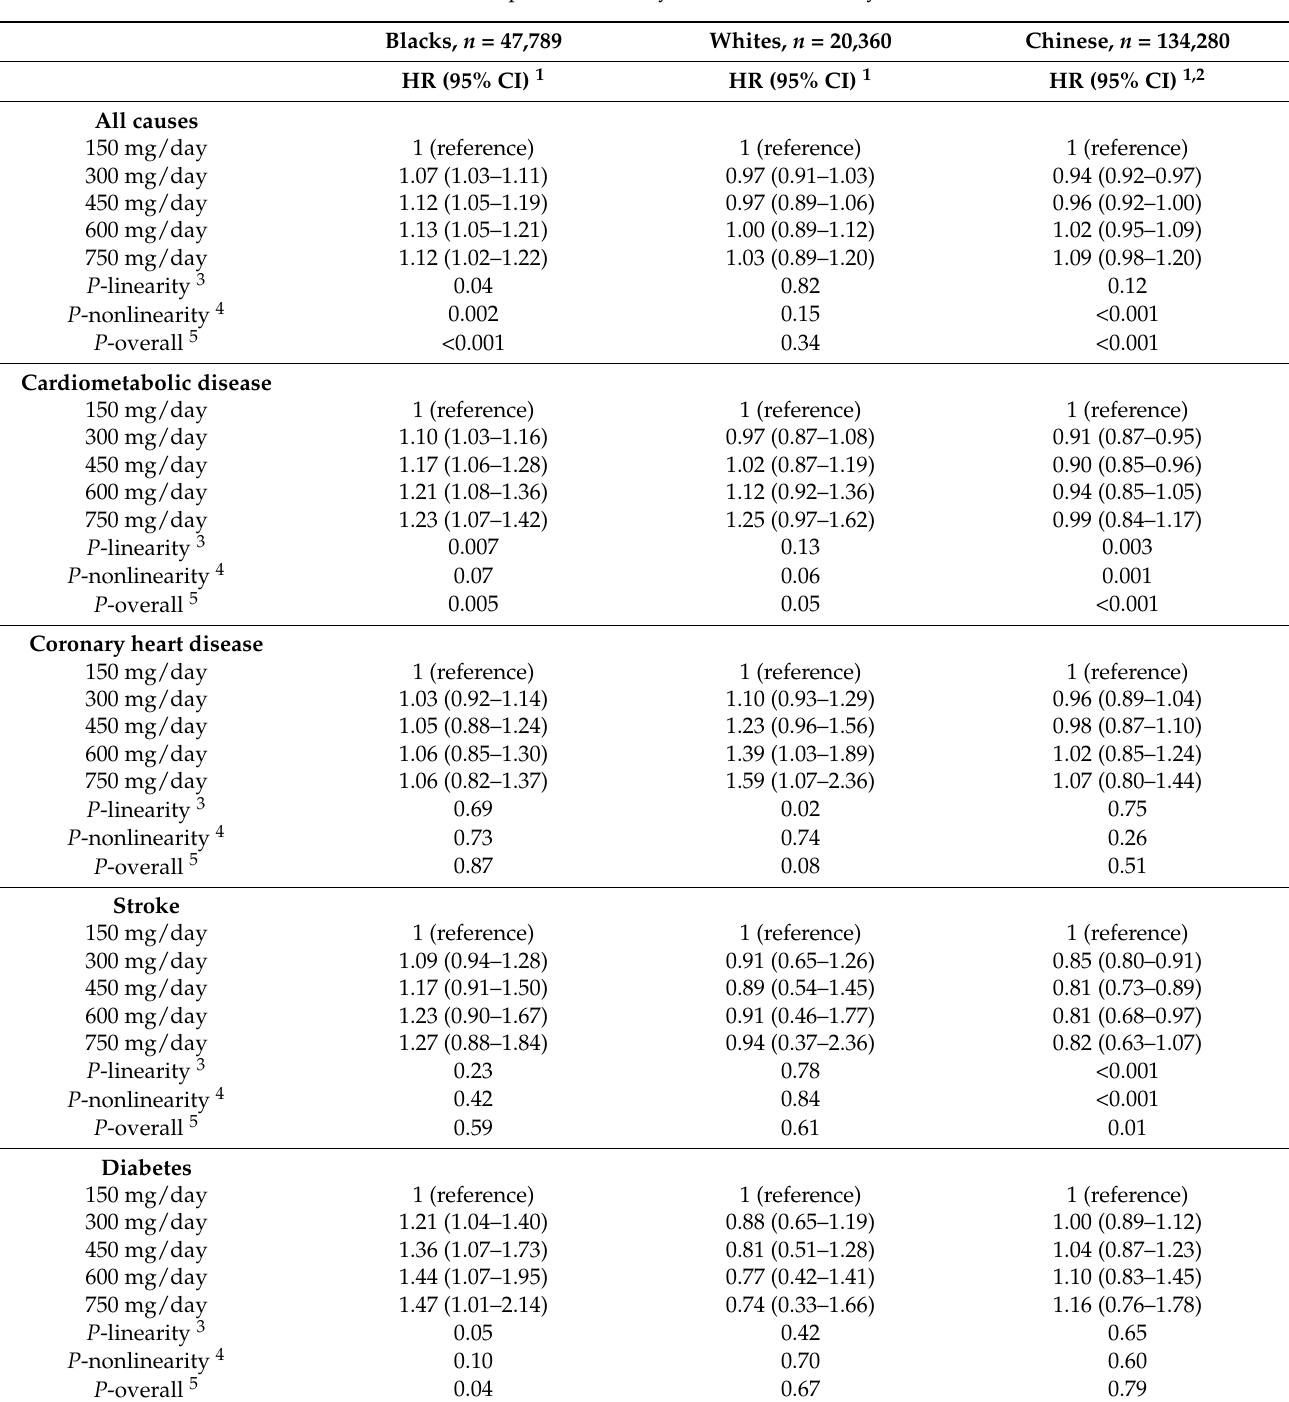
Table 2. All-cause and cause-specific mortality in relation to dietary cholesterol